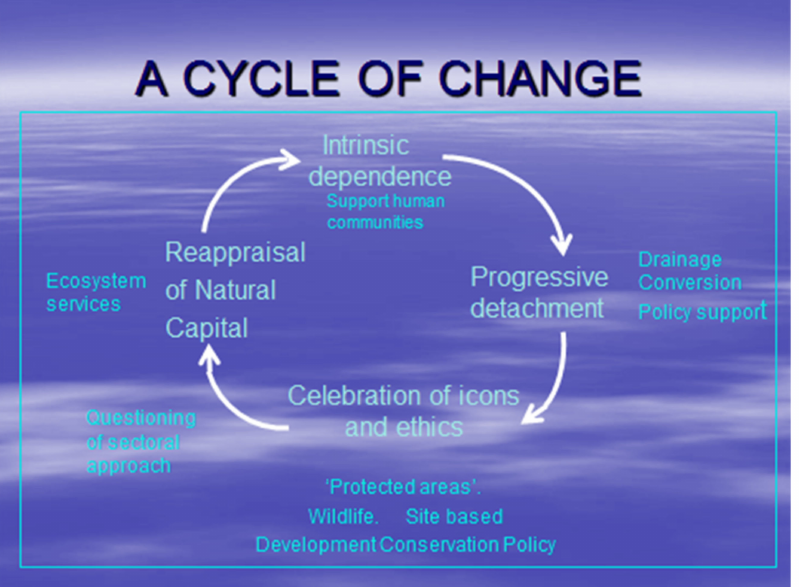
Figure 7. A simplified and generalized representation of the circle of change of the human interaction with wetlands. Source: Edward Maltby.